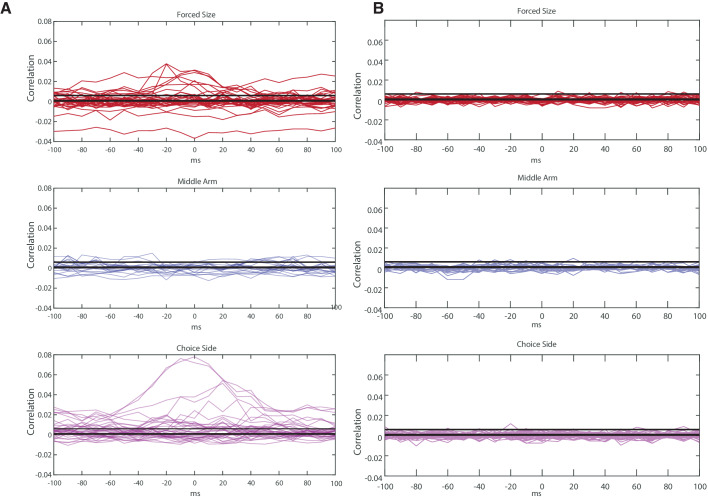
Cross correlation between all coupled pairs of HPC and LS cells, based on place field location.Cross correlation is across a lag of -100 to 100ms. (A) Top panel: correlations between firing of cells with place fields on the forced side of the maze. Upper black bar represents average peak correlation for cells with fields on the choice size. Lower black bar(s) (too close together to be separate) represent average peak cross correlation for place fields in the forced and middle arms. Middle: Same as top but for cells with fields in the middle arm. Bottom: Same but for cells with fields on the choice size. (B) Same as A but for shuffled spike trains. We shuffled the spike trains of all the HPC and LS pairs on the forced arm and found an average correlation of 7.71e-05, with a 95% confidence interval of [-8.89e-05, 2.43e04]. Out of 36 unit pairs on the forced arm, the average of 26 of these pairs (72%) fell above the 95% confidence interval for shuffled data.